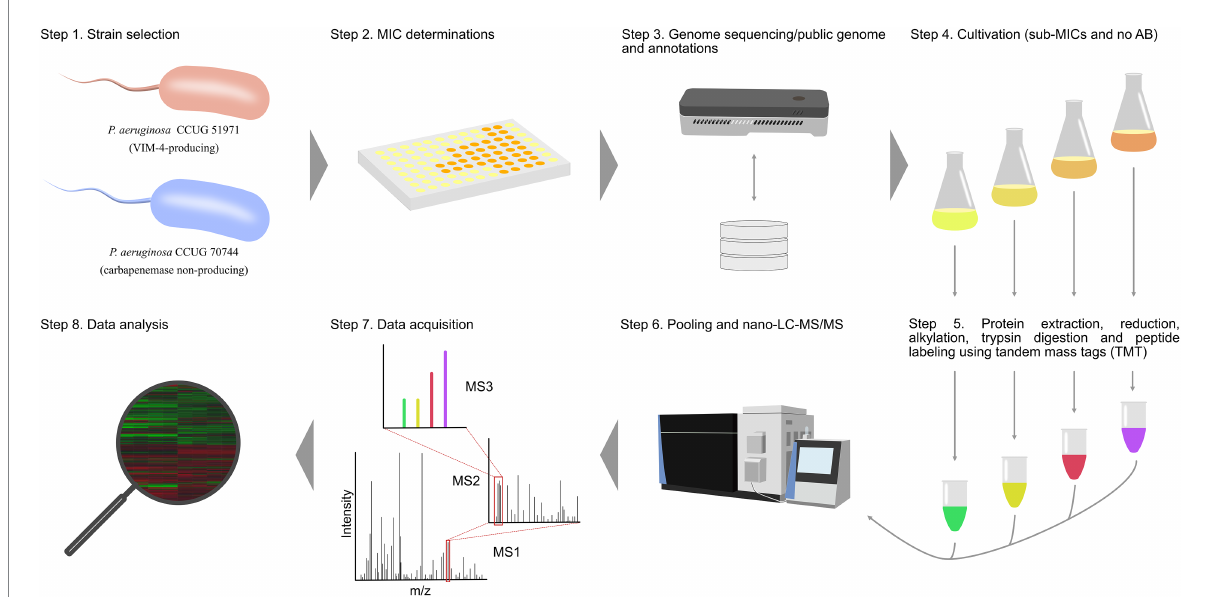
FIGURE 1 Experimental setup of the study. Each strain was cultivated with three different sub-MICs of meropenem and without antibiotic. Subsequently, proteins were extracted, reduced, alkylated and digested with trypsin. Peptides were labeled, using two TMT sets, pooled and analyzed, using nano-LC–MS/MS for protein detection and relative